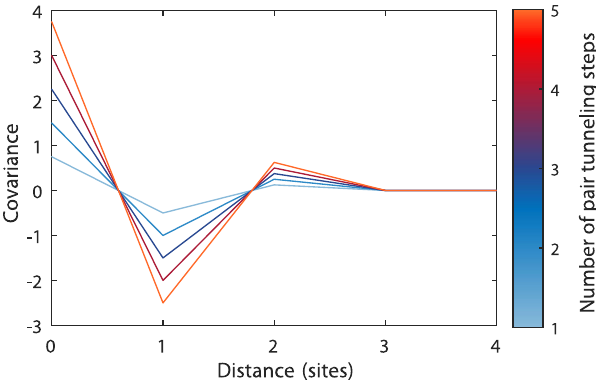
FIG. 7. Pair tunneling as mechanism for density-wave forma- tion. The figure shows the mean covariance of all states con- nected to an initial homogeneous state of a system of 9 lattice sites with periodic boundary conditions with N events (color coded starting from N ¼ 5 in orange). The covariance shows clear staggered N steps correlations for up to 2 lattice sites